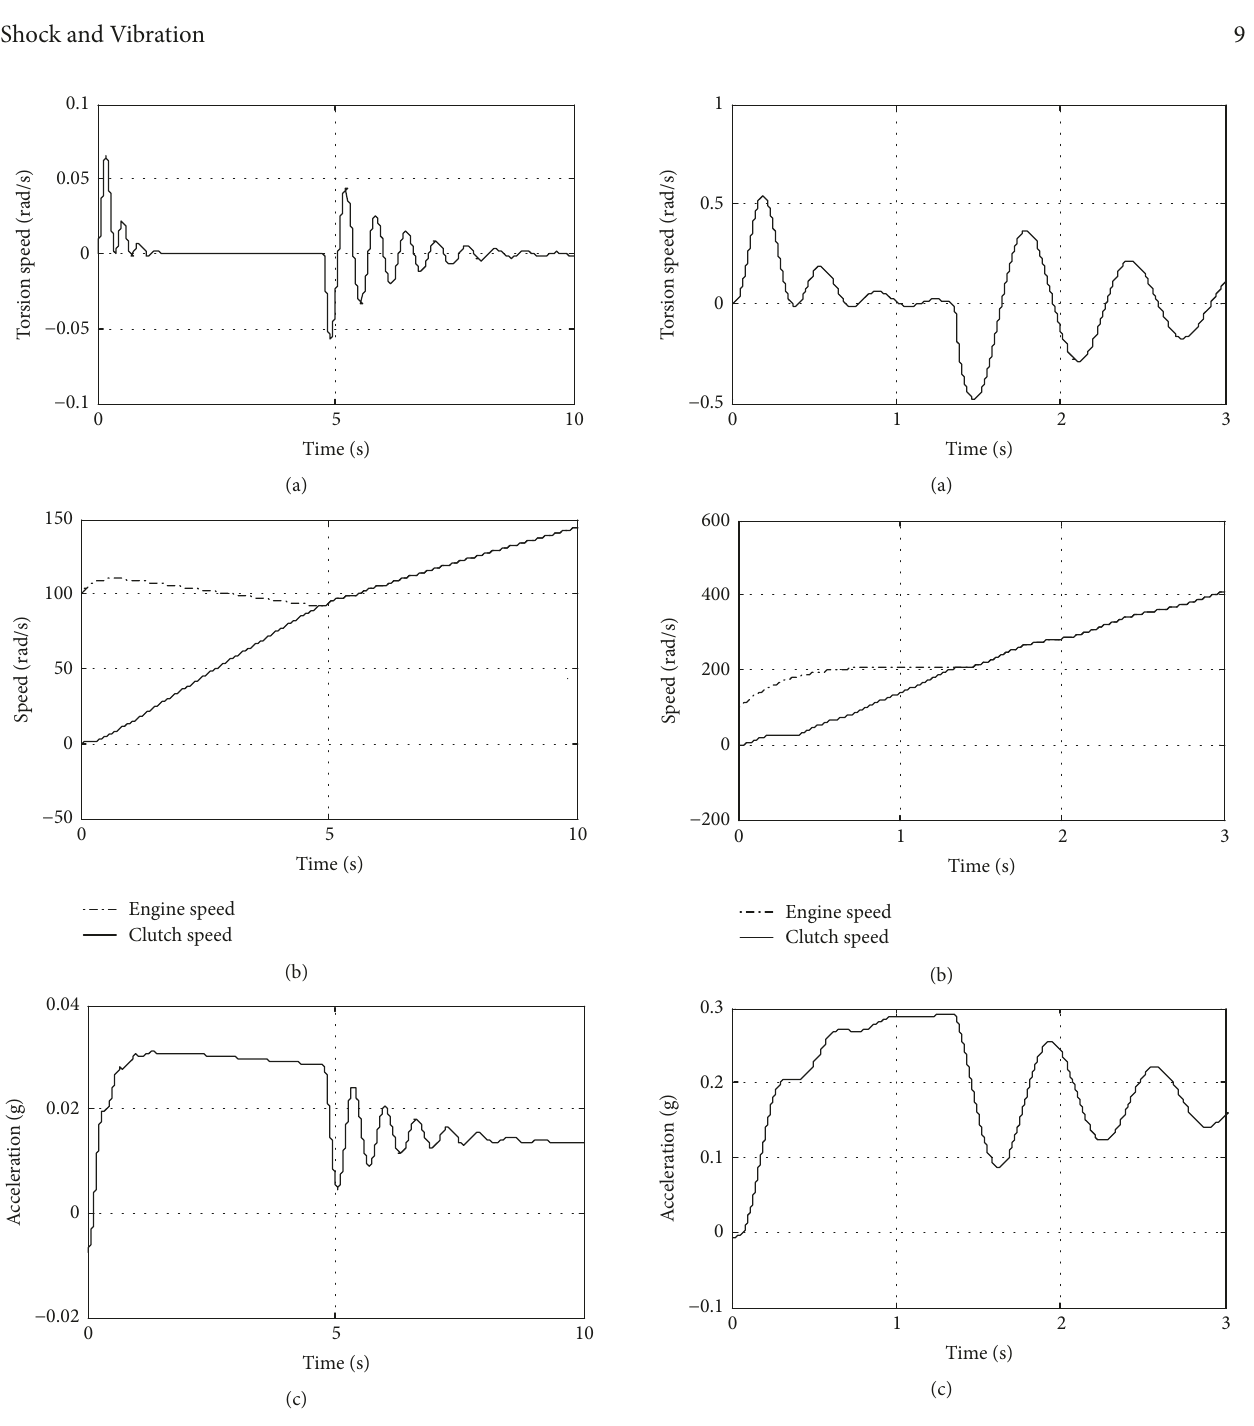
Figure 8: M1 maneuver simulation results.